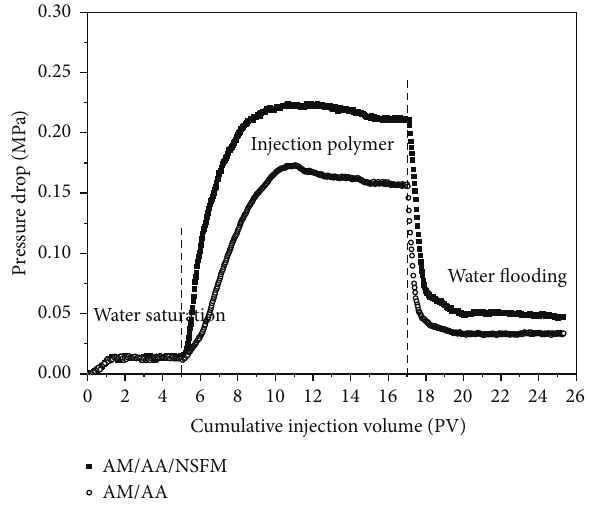
Figure 11: Flow characteristic curves of AM/AA and AM/AA/ NSFM solution (0.2wt%). The length and internal diameter of the core barrel were 25.0 cm and 2.5 cm, respectively.